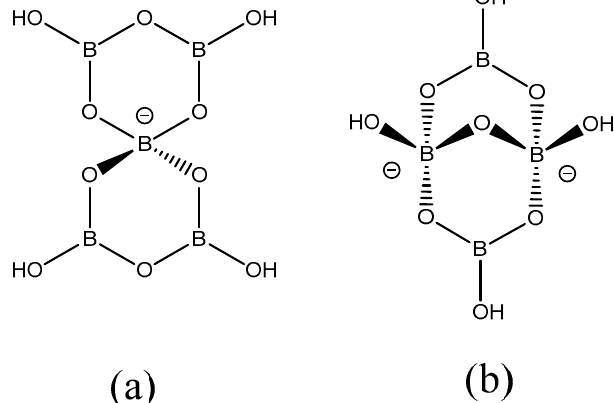
Figure 1. Schematic drawings of ( a ) pentaborate(1-) anion observed in 1 – 8 , and ( b ) tetraborate(2-) anion observed in 9 .